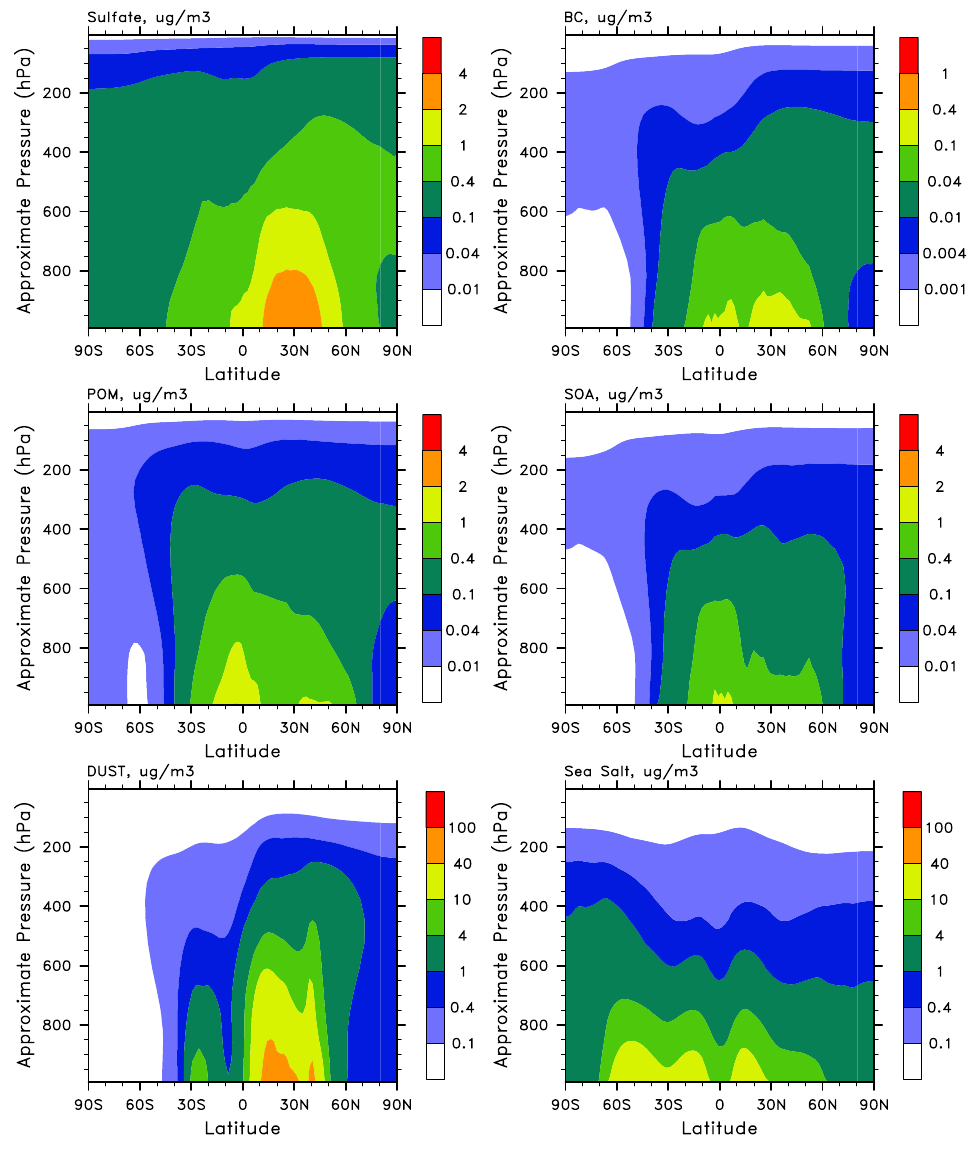
− 3 ) of sulfate, BC, POM, SOA, dust and sea salt predicted by the model. The host Figure 02 Fig. 2. Annual averaged zonal mean concentrations (ugm GCM model (CAM5) used a hybrid vertical coordinate and the pressure at the k th model level is given by p(k) = A(k)p 0 + B(k)p s , where p s is surface pressure, p 0 is a specified constant pressure (1000hPa), and A and B are coefficients. Data are plotted as a function of this hybrid vertical coordinate times 1000, and labelled “Approximate